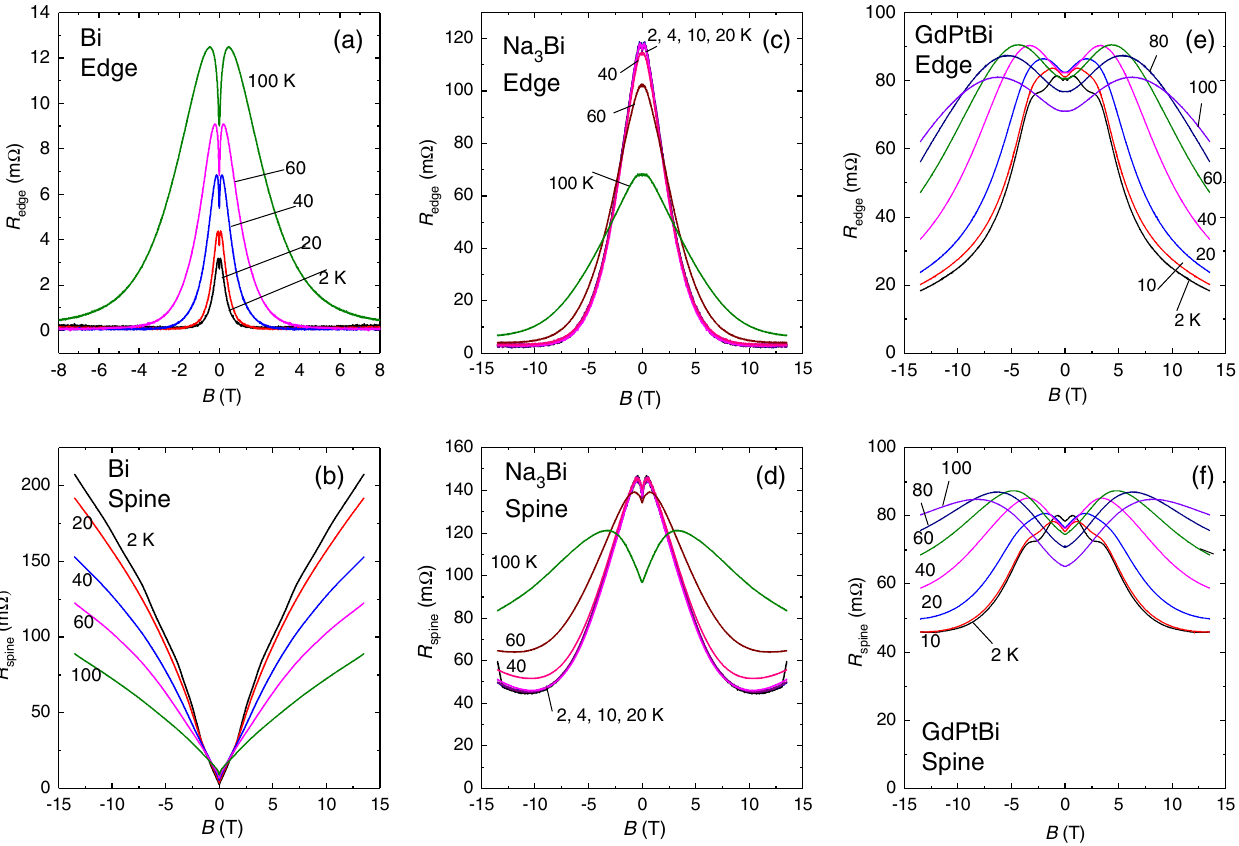
FIG. 2. Comparison of squeeze-test results in pure bismuth (case 1) and in Na 3 Bi and GdPtBi (case 2). Panels (a) and (b) display the voltage drops V and V (expressed as R and R , respectively) measured in Bi (sample B1). In panel (a), R displays a edge spine edge spine edge steep decrease with increasing B that steepens as T decreases from 100 K to 2 K. By contrast, R increases steeply. The opposite spine trends in (a) and (b) imply that both arise from pure current jetting, strictly reflecting changes in L e and L s , respectively [Eqs. (9) and (10)]. By contrast, in Na 3 Bi (sample N1), both R decrease with B [panels (c) and (d), respectively]. This implies that ρ xx ð B Þ edge decreases uniformly throughout the sample. Nonetheless, current focusing effects (expressed by L e and L s ) are visible. Below 20 K, L e exaggerates the decrease in R , while L s counters some of the intrinsic decrease in R . A telling feature is the weak upturn in R edge spine spine above 10 T. When the intrinsic LMR is saturated, L s produces a weak increase in R . In GdPtBi [sample G1, panels (e) and (f)], both spine R and R also decrease with increasing B . Below 10 K, the decrease in R is much larger than that in R . The latter also edge spine edge spine attains a broad minimum above 10 T (but not the former). These features confirm that L e amplifies the growth in the intrinsic LMR, while L s partially counters